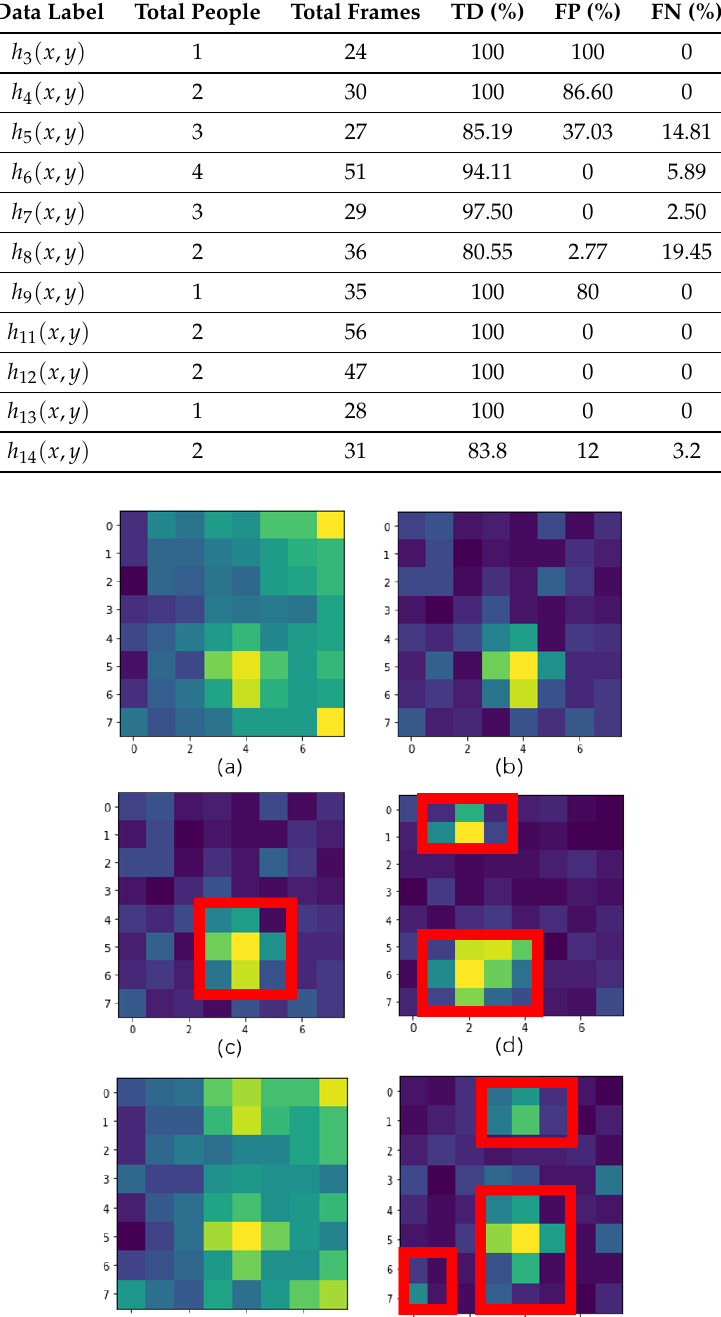
Table 2. Performance of the computer vision based method on each recording which includes at least one person in the scene.